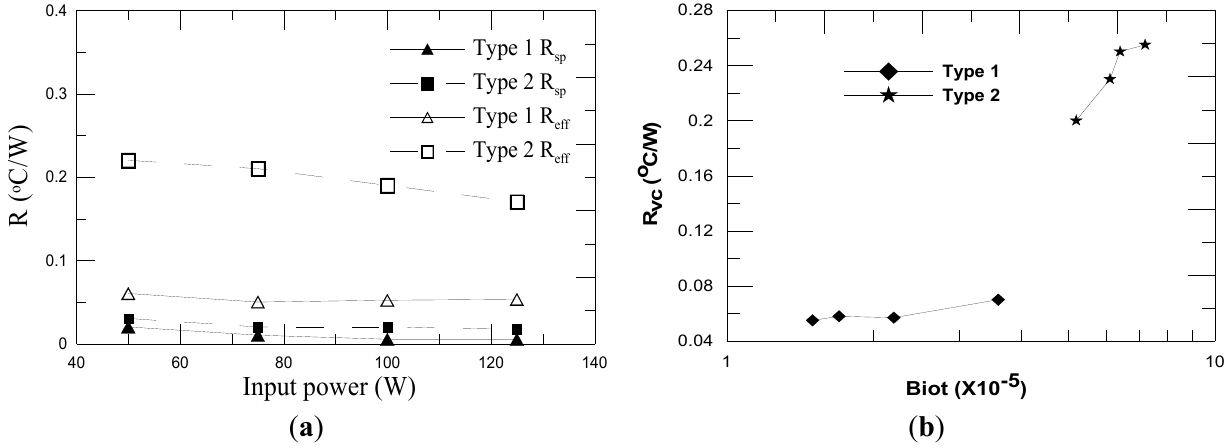
Figure 3. ( a ) R and R of the two heat pipes changing with the input power; ( b ) Thermal eff sp resistances of the two heat pipes changing with the Biot number (Bi).